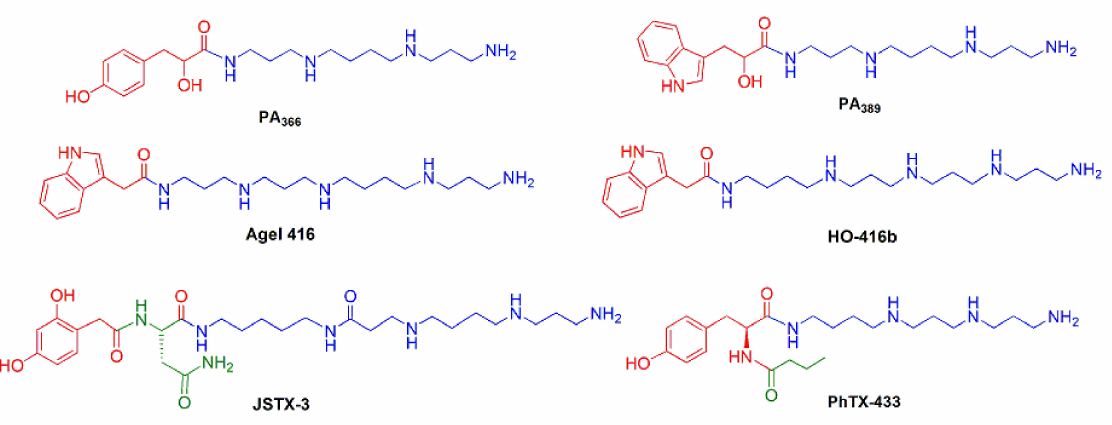
Figure 1. Structures of natural PATs from spider and wasp venoms related to the present